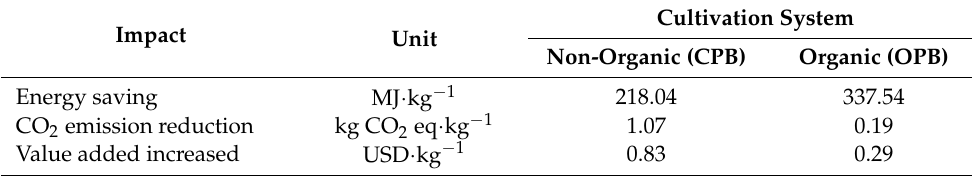
Table A6. Potential energy reduction per kilogram of green coffee